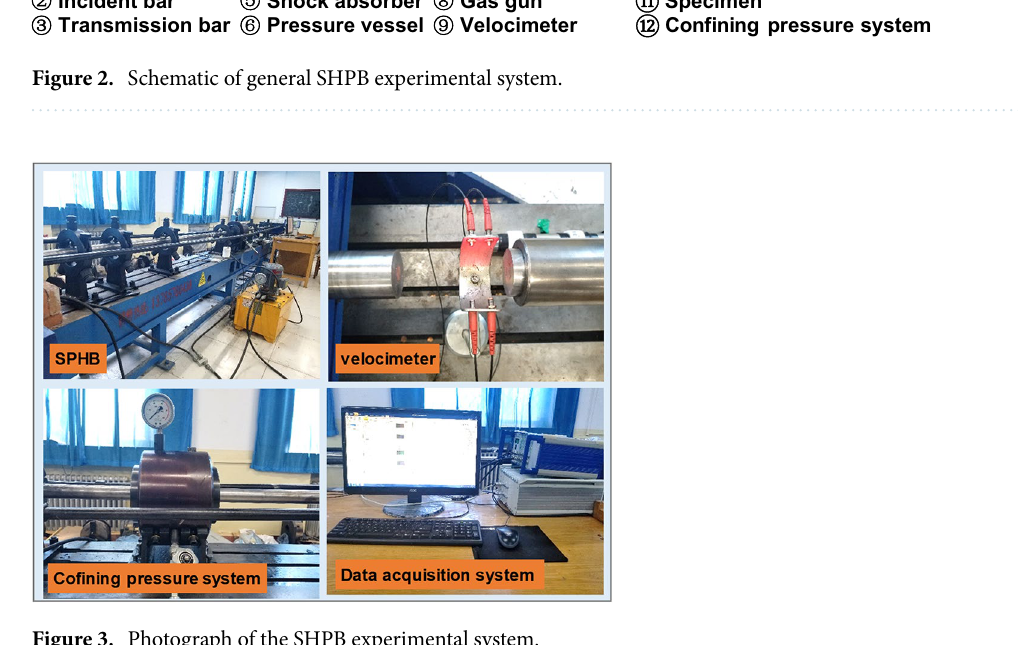
Figure 3. Photograph of the SHPB experimental